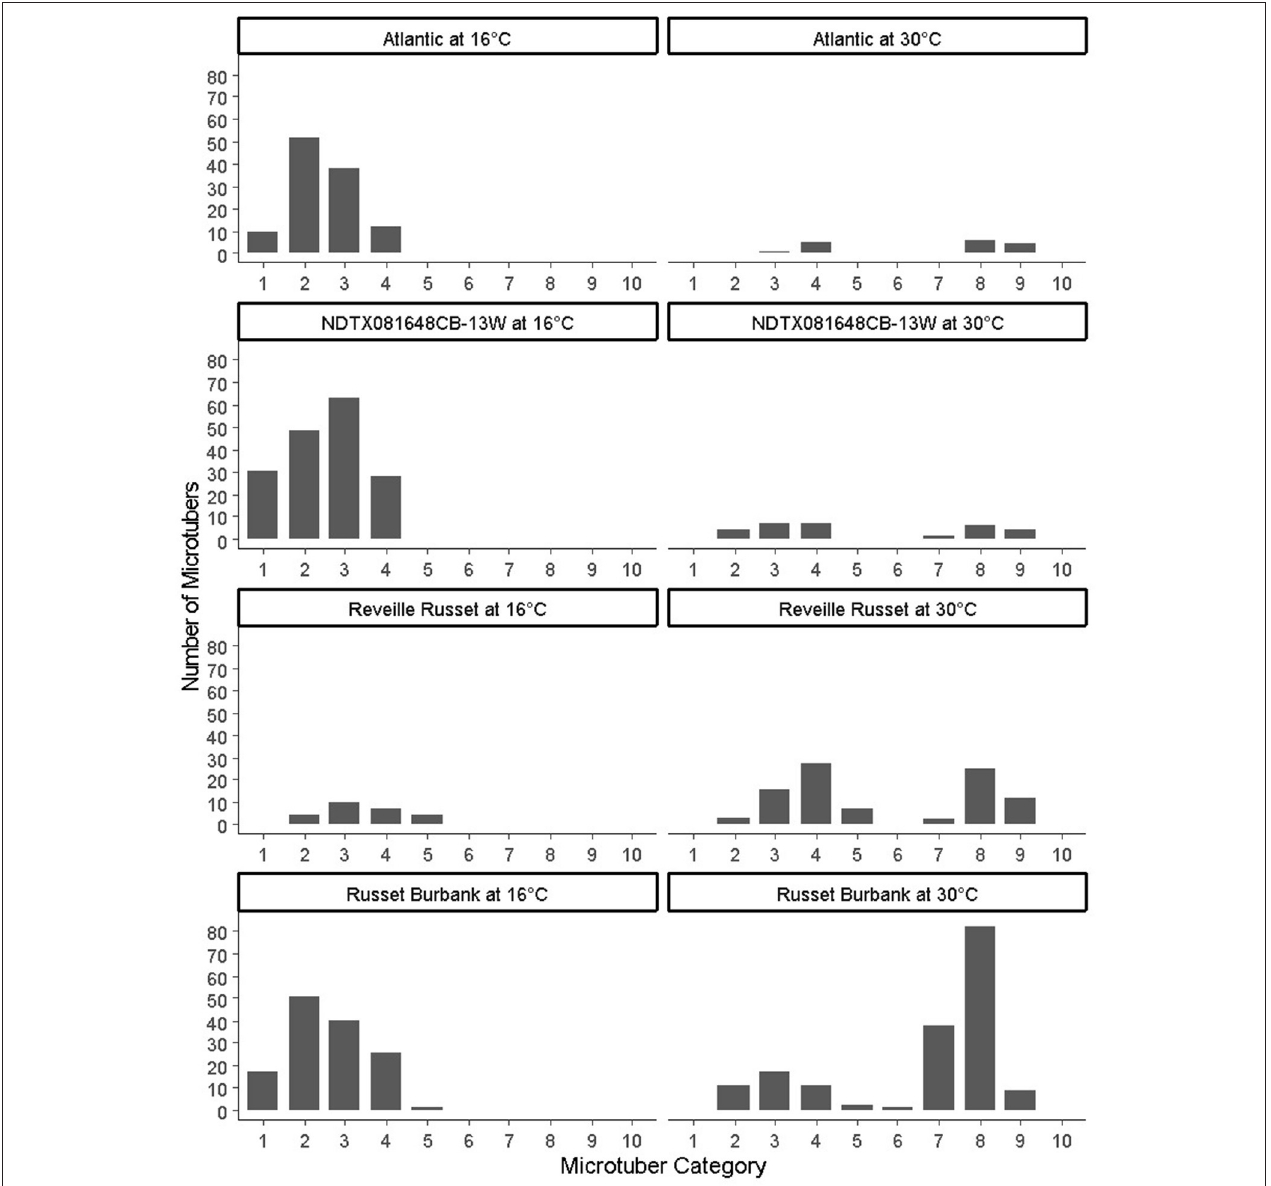
FIGURE 2 | Distribution of microtubers per bioreactor based on the following categories: (1–5) indicate the size (diameter) of non-deformed microtubers (1: up to 2mm, 2: 2–4mm, 3: 4–8mm, 4: 8–20mm, 5: > 20mm), (6–10) indicate the size of deformed microtubers (6: up to 2mm, 7: 2–4mm, 8: 4–8mm, 9: 8–20mm, 10: >